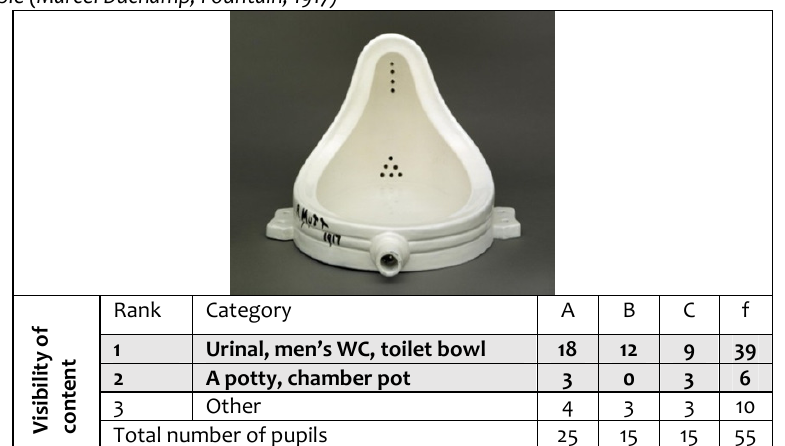
Table 13: Ranking order of categories of answers regarding the visibility of content of the fifth example (Marcel Duchamp, Fountain, 1917)